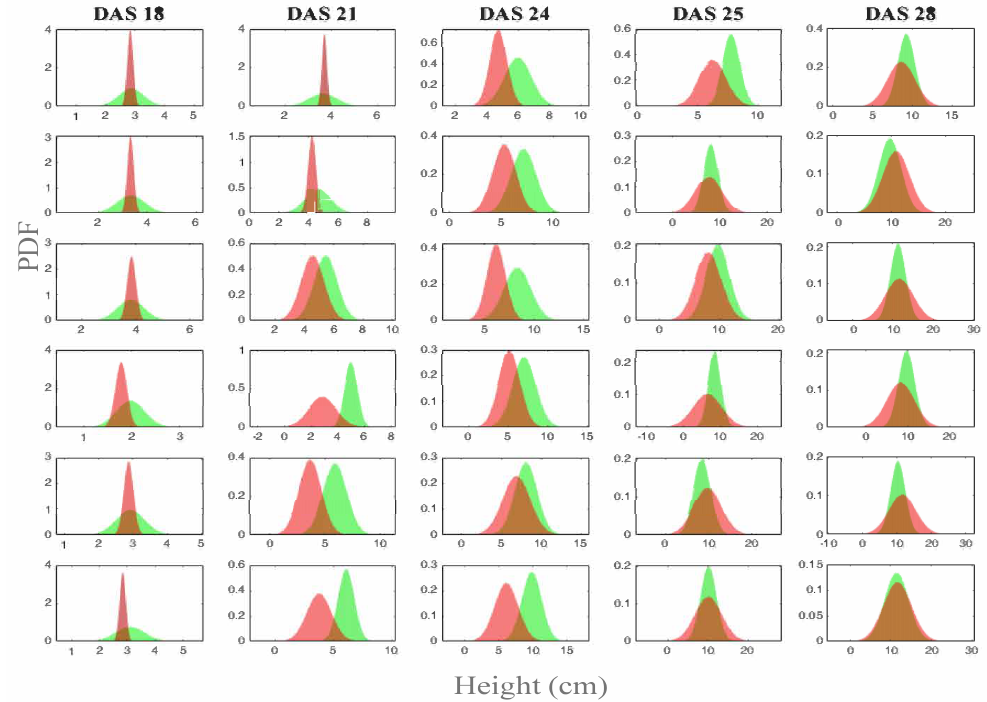
Figure 10. Plants height distribution for DAS 18, 21, 24, 25 and 28, and for Racks 7–12. Recall that Racks 7–9 are low density, while Racks 10–12 are high density. In green is the probability density function (pdf) generated by the mean and variance of the manually collected height measures, and in red is the pdf generated by the predicted mean and variance. Note that the pdf does not need to be up to 1. We preferred to give the pdf because it better highlights the increase of the variance as DAS increases, and it shows that it is also wider for low plant density